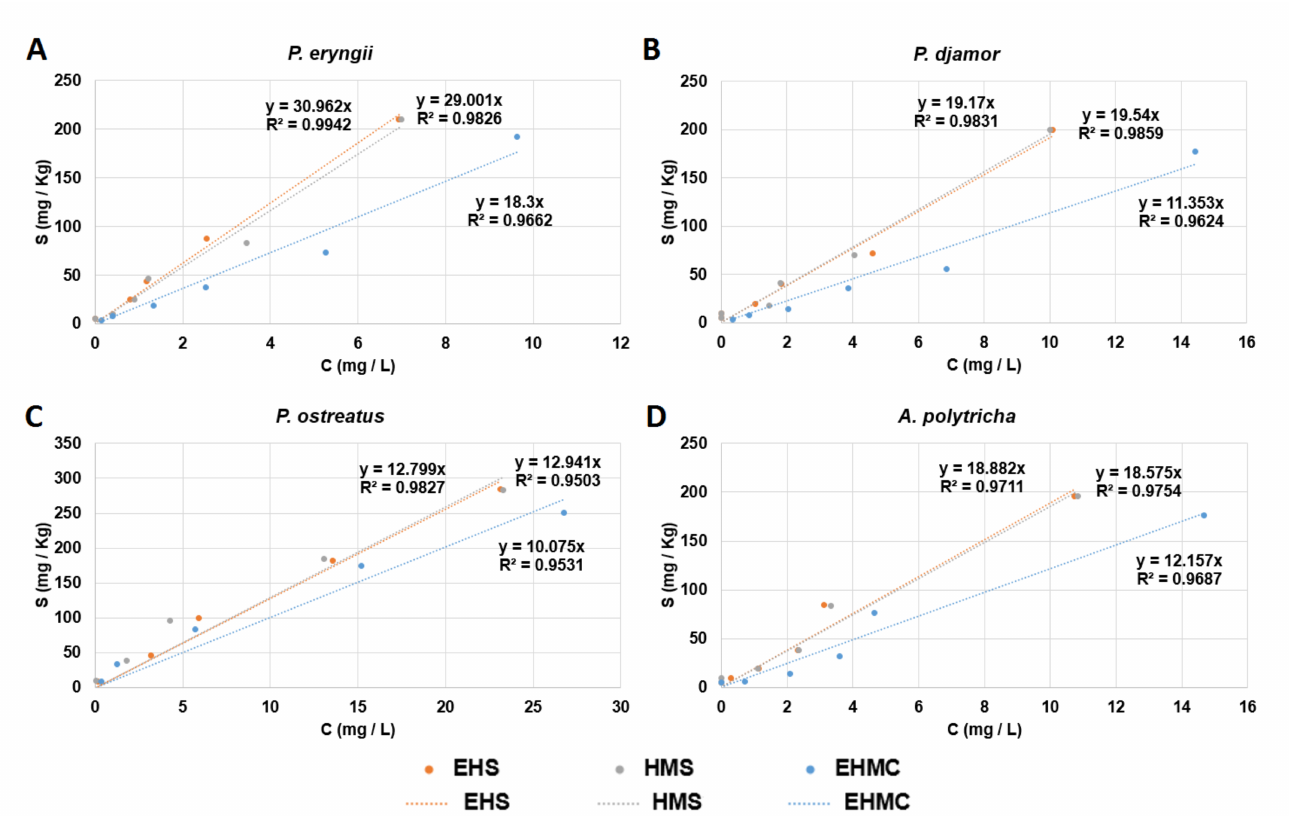
Figure 6. Linear adsorption isotherm of the spent mushroom compost of four mushrooms (( A ) P. eryngii , ( B ) P. djamor , ( C ) P. ostreatus and ( D ) A. polytricha ). The label of the y -axis, S, is the concentration of the substrates (EHMC: ethylhexyl methoxycinnamate, EHS: 2-ethylhexyl salicylate, HMS: homosalate) in the solid phase. The label of the x -axis, C, is the concentration of the substrates (EHMC, EHS and HMS) in the aqueous